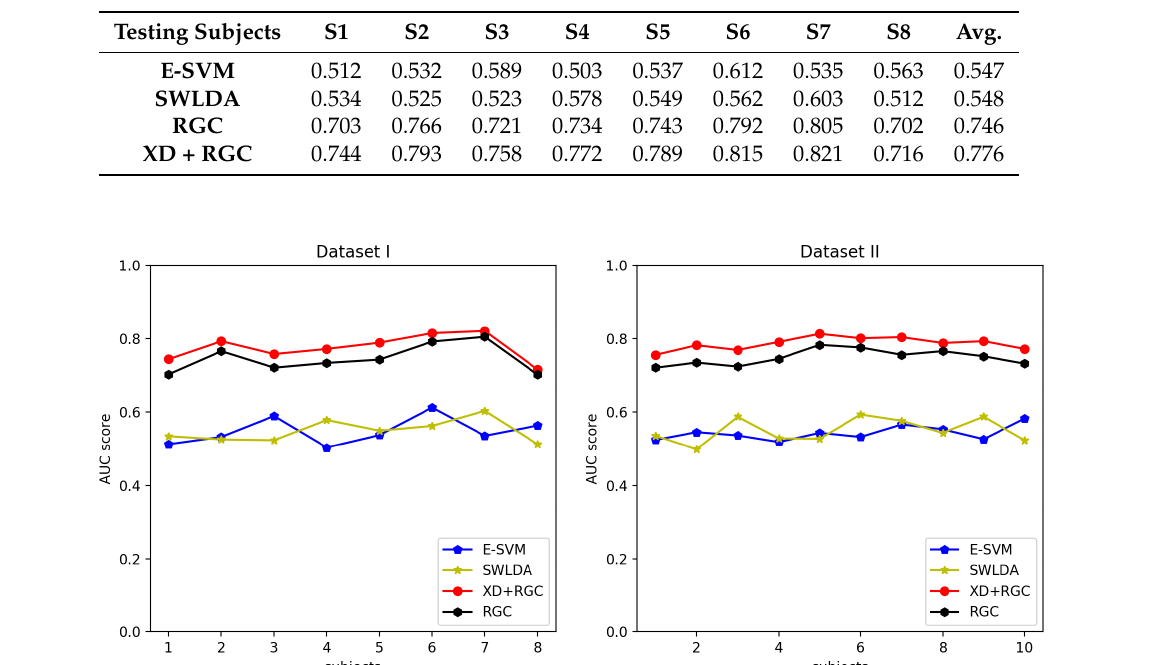
Table 3. One-to-One transfer learning results of Dataset I. The first row represents the testing subject. The second and third rows represent the AUC score results obtained using the classic E-SVM and SWLDA methods. The fourth row represents the results obtained by our proposed XDAWN + RGC method. The last column represents the average AUC value of all subjects.